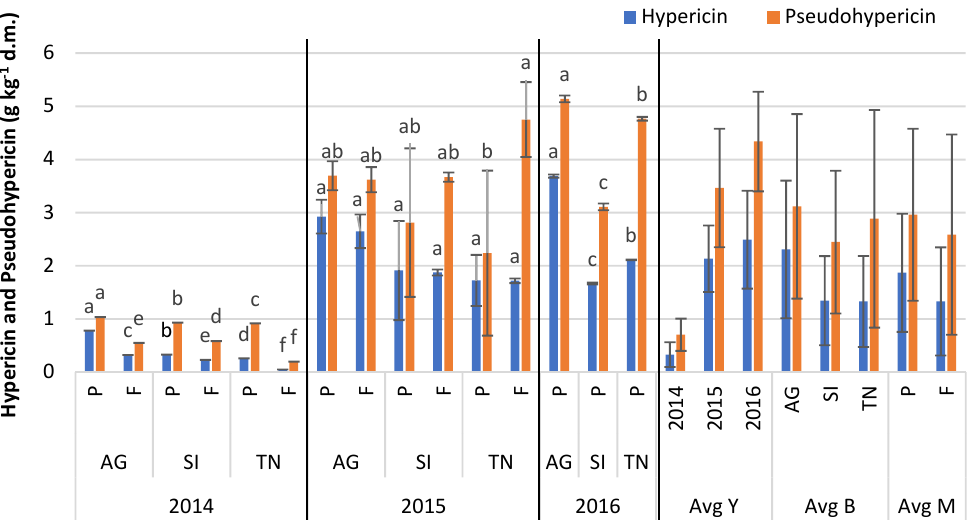
Figure 7. Mean values of hypericin and pseudohypericin content (g kg − 1 d.m.) in flowering tops of 3 biotypes of H. perforatum (AG, SI, and TN), obtained in 2014, 2015, and 2016 from cultivations in pots (P) and in open field (F). Within each year and compound, means that do not share a letter are significantly different at P ≤ 0.05 (Tukey’s test). Avg Y—averages by year; Avg B—averages by biotype; Avg M—averages by cultivation management.